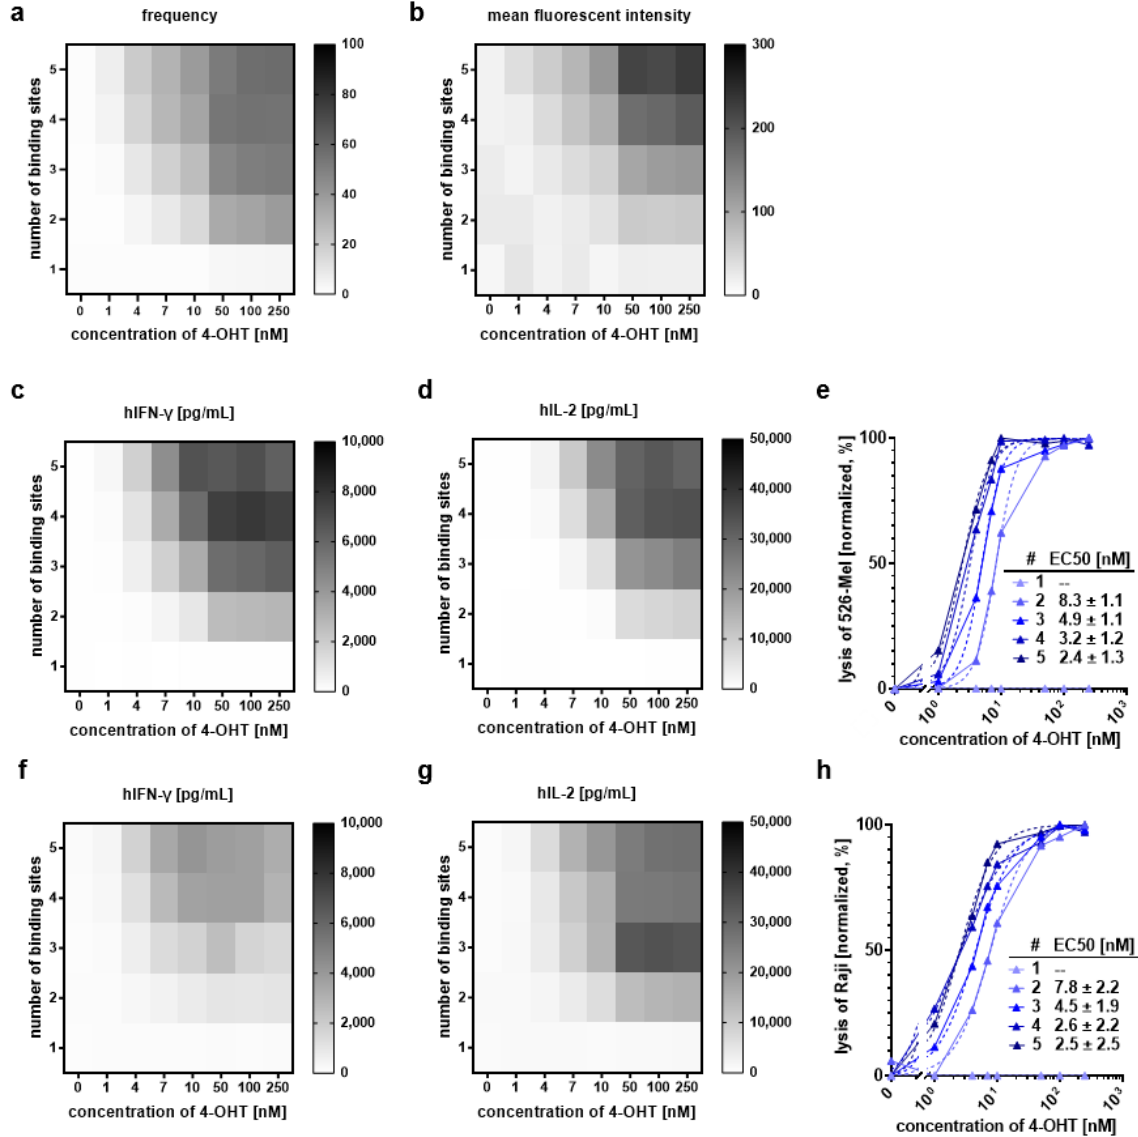
Figure 3. Modulation of anti-CD20 CAR induction by the inducer dose and the number of response elements. ( a , b ) Inducible CAR T cells bearing one to five binding sites for the synthetic transcription factor were induced with varying concentrations of 4-OHT. Cell surface expression of anti-CD20 CAR was determined after 40 h by flow cytometry using anti-CD20 CAR detection reagent-PE. Data for frequency ( a ) and MFI ( b ) of anti-CD20 CAR T cells are normalized to the expression of the transduction marker ∆ LNGFR. ( c – h ) Inducible CAR T cells bearing one to five binding sites for the synthetic transcription factor were co-cultured with GFP + CD20 + 526-Mel (upper panel) or GFP + Raji (lower panel) for 40 h at an E – T ratio of 1:1 in the presence of varying concentrations of 4-OHT. ( c , d , f , g ) Human IFN- γ and IL -2 levels were detected in the culture supernatant by MACSPlex Cytokine 12 Kit. ( e , h ) Titration curves were determined for the lysis of GFP + CD20 + 526-Mel and GFP + Raji. Non-linear regression was performed to calculate EC 50 values following log transfor- mation and normalization of data. Graphs show data from n = 5 ( a , b , e , h ); n = 2 ( c , d , f , g ) different donors. 2.5. Inducible CAR T Cells Efficiently Eradicate Disseminated Lymphoma In Vivo As tight expression control is a key feature of drug-inducible CAR T cells, an in vivo study was designed to detect any potential residual CAR activity in the absence of the inducer drug, as well as to analyze therapeutic activity of the CD20 CAR T cells in its presence. Therefore, we applied a progressive model of Burkitt lymphoma (Raji ffLuc cells) in immunodeficient NOD.Cg- Prkdc scid IL-2rg tm1Wjl /SzJ (NSG) mice. Mice received 3 × 10 6 transduced (∆LNGFR + ) T cells in a total of 1.1 × 10 7 T cells, or 1.1 × 10 7 control T cells